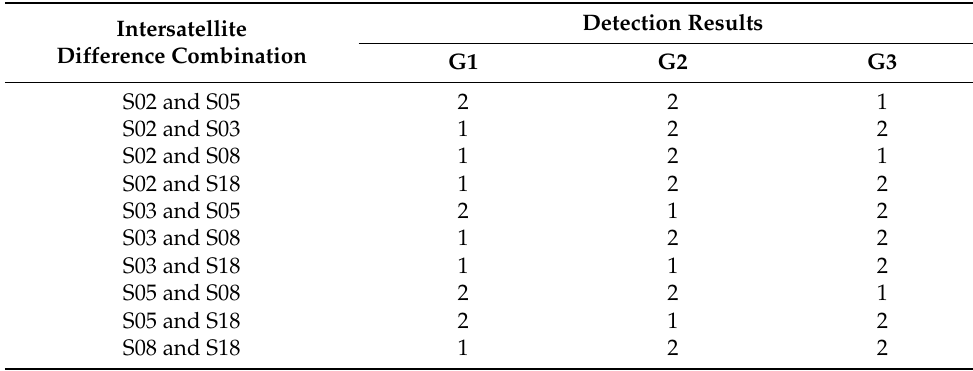
Table 6. IPNN network detection results.